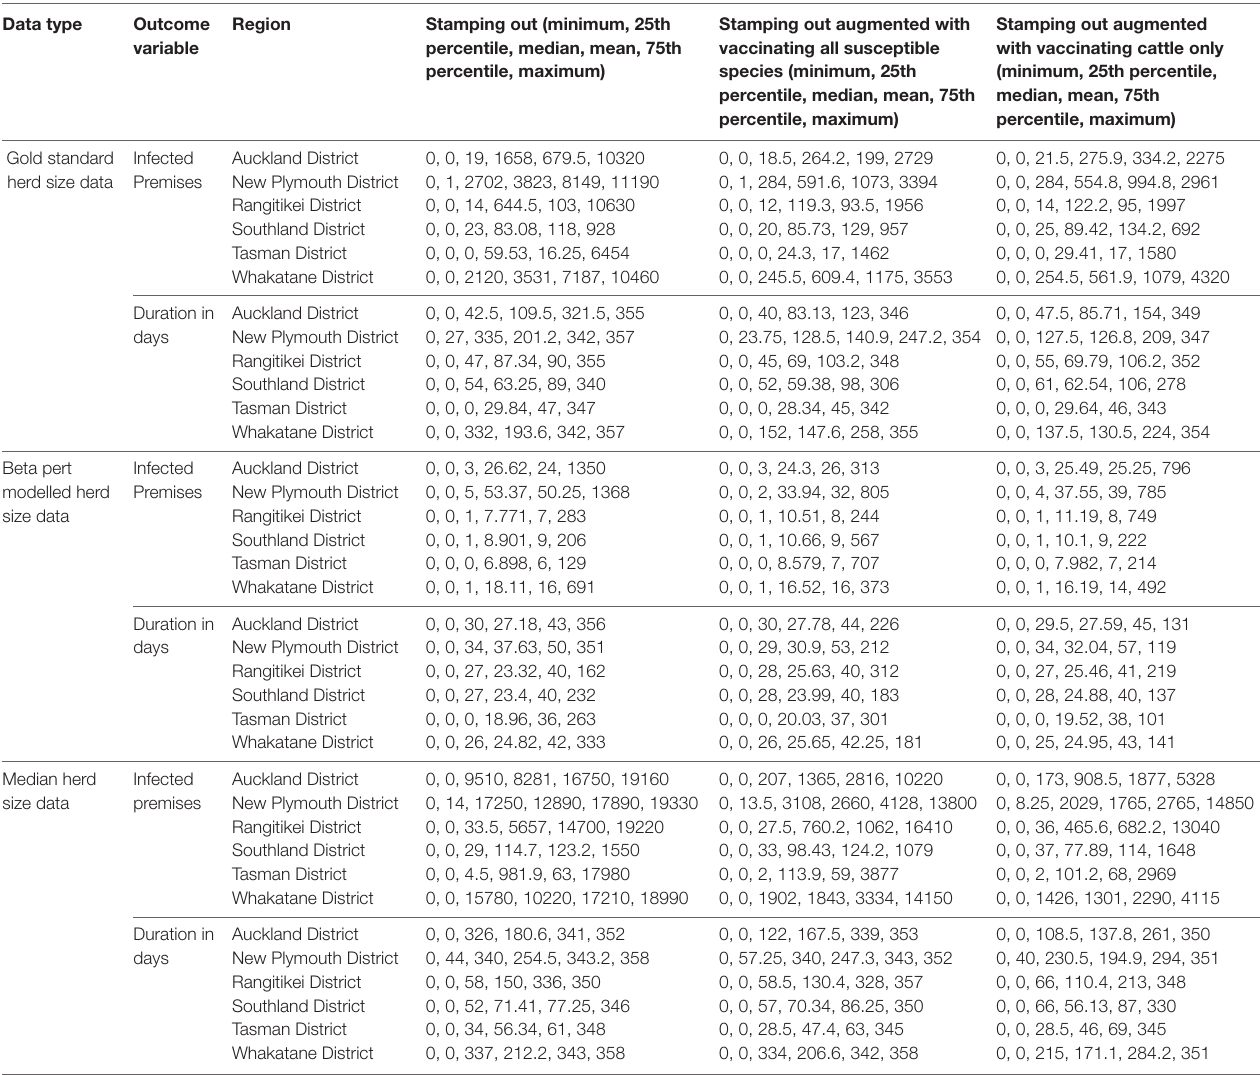
Table a1 | Descriptive five number summaries (minimum, 25th percentile, median, mean, 75th percentile and maximum) for each of 2 outcome variables (count of infected premises and duration in days) and 3 explanatory variables for the models described in Table 4